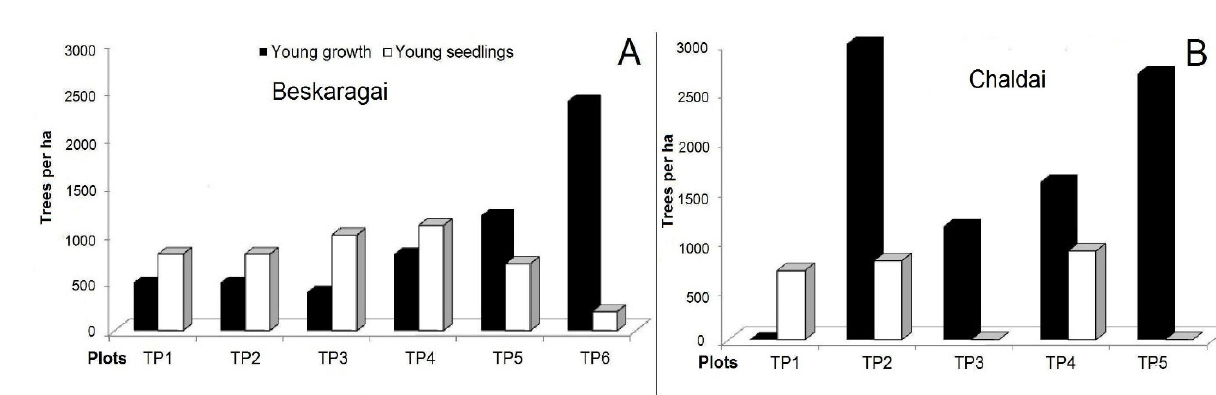
Figure 8. Restoration of pinetums of the Beskaragai ( A ) and the Chaldai ( B ) pine